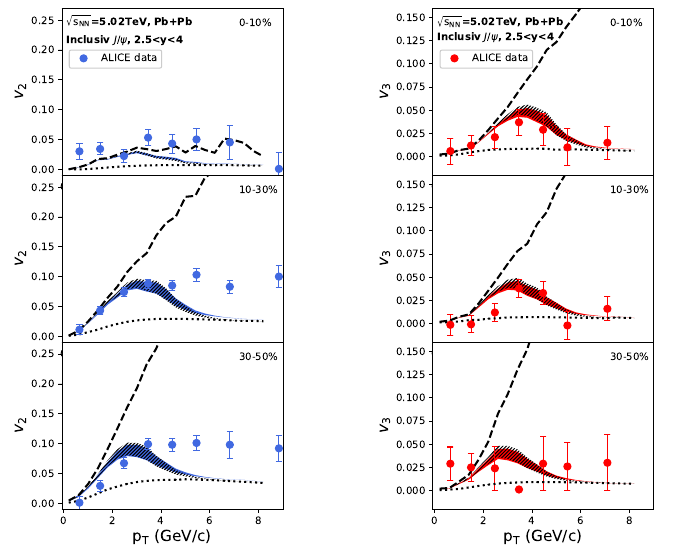
√ s NN = 5.02 TeV Pb-Pb collisions.